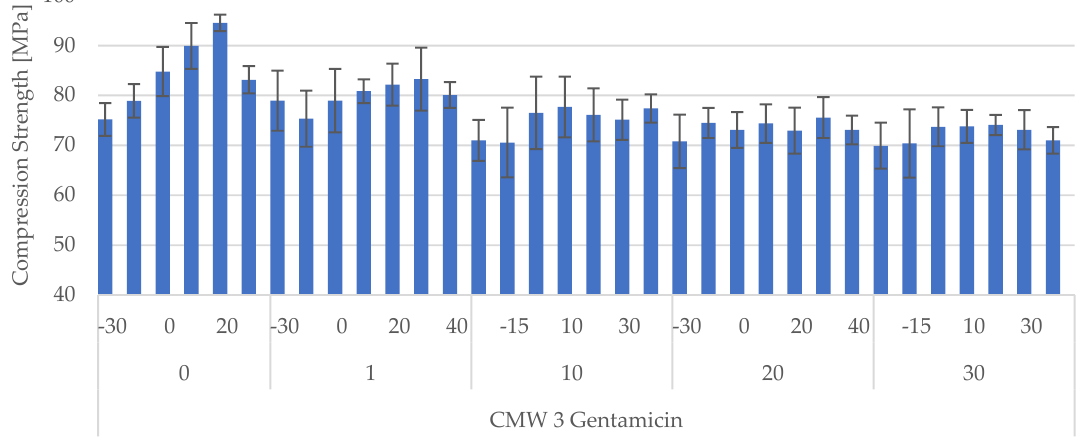
Figure 4. Change in average compressive strength of the cements tested as a function of their com- position: ( a ) − 30% liquid part (l.p.), ( b ) − 15% l.p., ( c ) correct ratio, ( d ) +10% l.p., ( e ) +20% l.p., ( f ) +40% l.p.